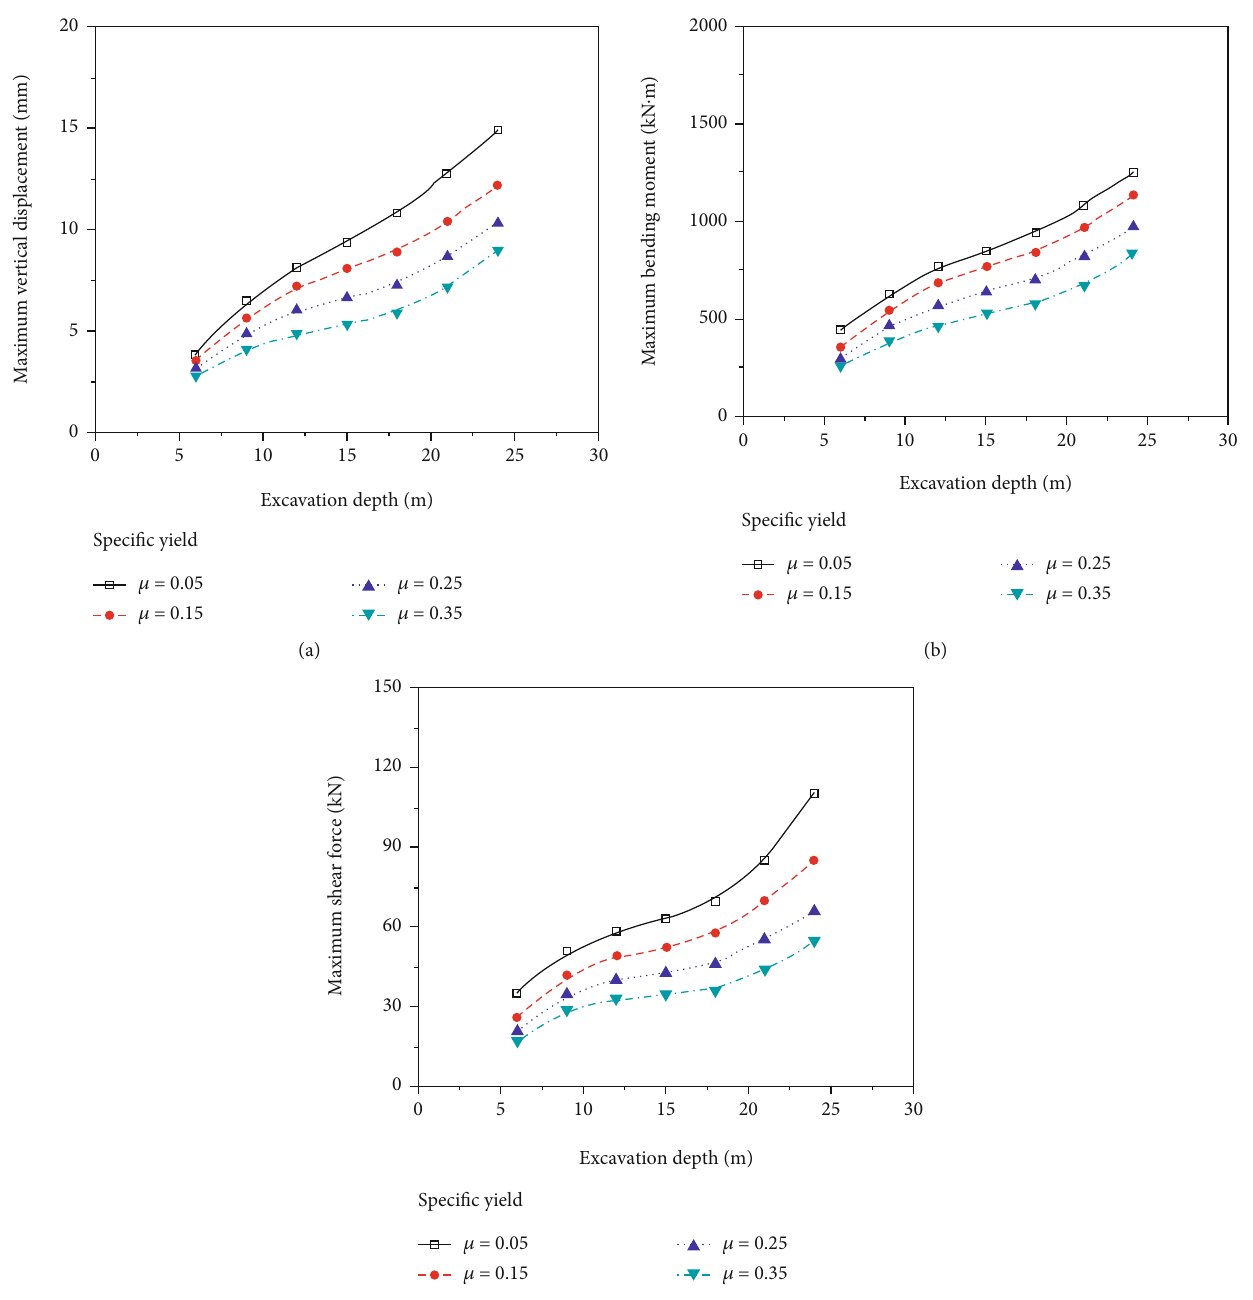
Figure 14: E ff ects of the excavation depth on (a) tunnel maximum vertical displacement; (b) tunnel maximum bending moment; (c) tunnel maximum shear